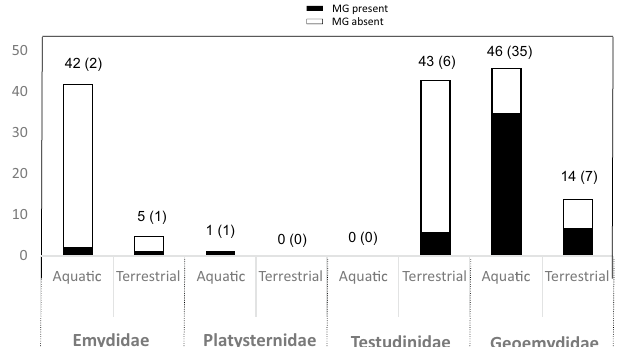
Figure 1. Summary of the number of species with and without mental glands (MGs) by family and habitat (based on the species included in the phylogenetic timetree of Pereira et al. 43 —i.e. 292 species). Total number of species in a family and habitat is shown at the top of the bar. The value in brackets is the number of species with MGs in a given category